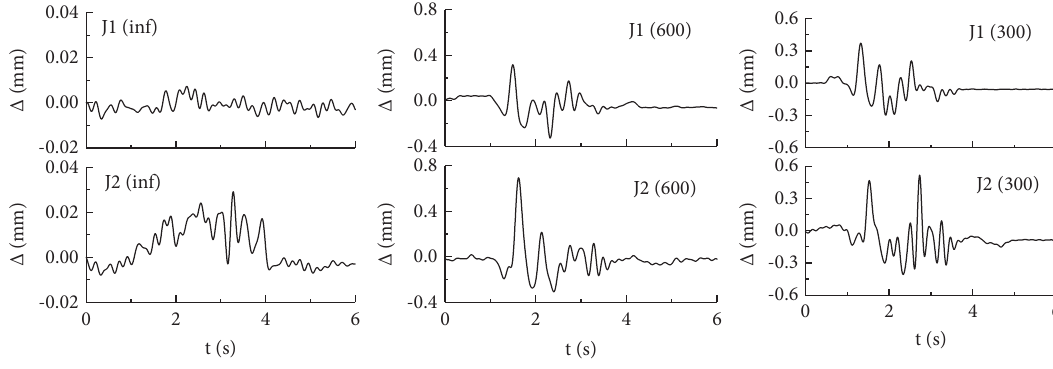
Figure 15: Deformation diagram of joints.